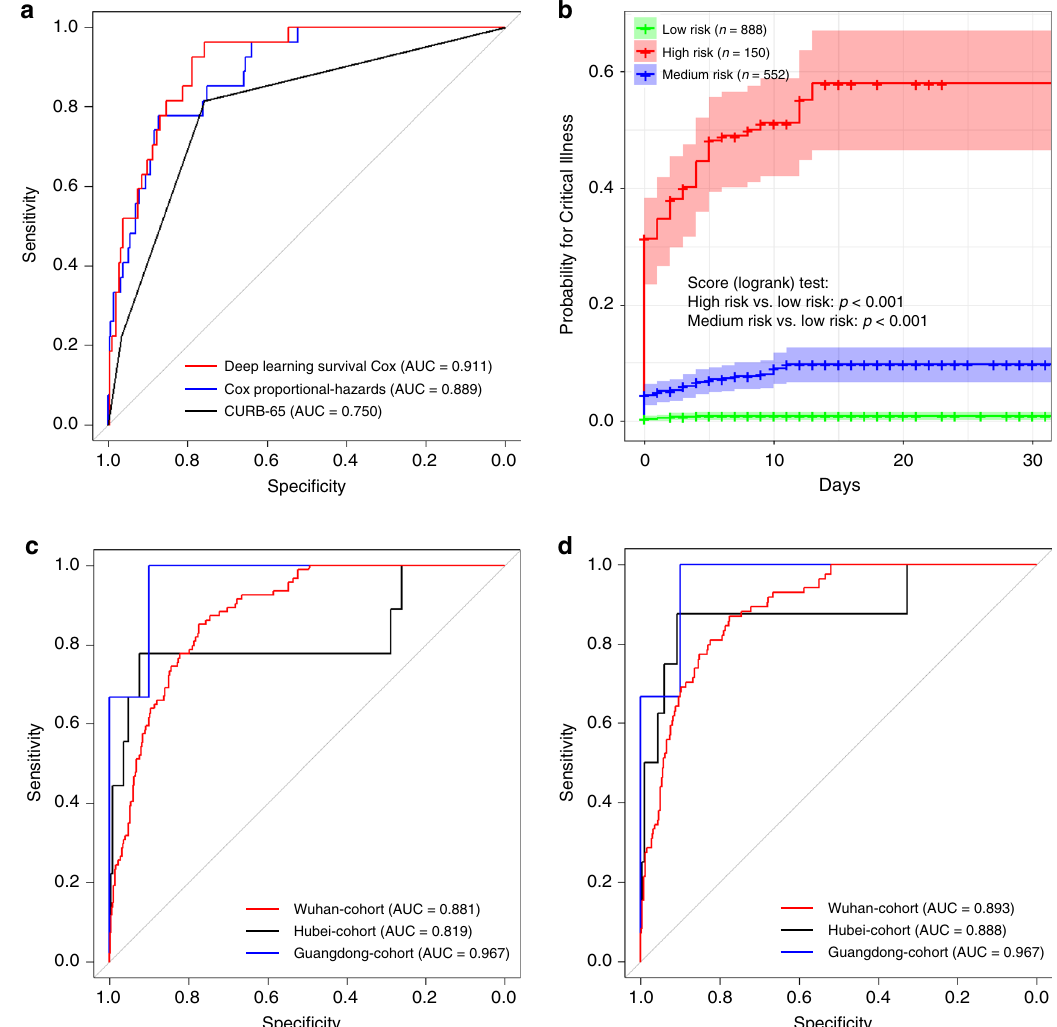
Fig. 1 Model performance comparison. a Comparison of ROC curves for the Deep Learning Survival Cox model and the Cox proportional hazards model on the training-validation set. b The Kaplan – Meier curves for developing critical illness among patients in different risk groups in the training set. Shaded areas indicate 95% con fi dence interval. c ROC curves for the three external validation cohorts using the entire datasets. d ROC curves for the three independent external validation cohorts, excluding patients that were missing more than three